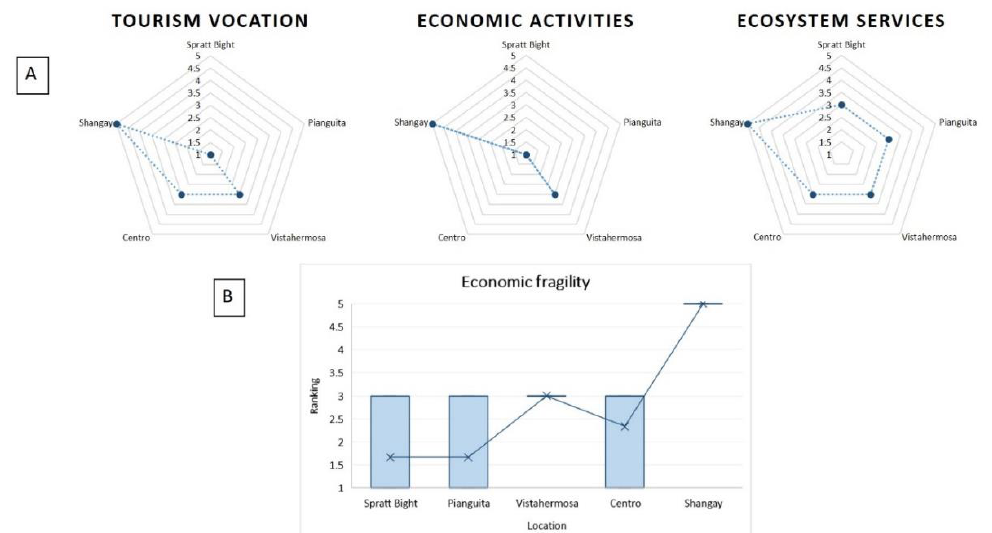
Figure 11. ( A ) Ranking of four variables representing economic fragility for two study areas (and five villages): San Andrés, Caribbean Coast (Spratt Bight) and La Bocana, Pacific Coast (Pianguita, Vistahermosa, Centro, Shangay) of Colombia. ( B ) Minimum and maximum values of economic fragility for each village and average rank. Results are shown by ranking, given that units of analysis are rank levels and not segments, as was the case for hazard.